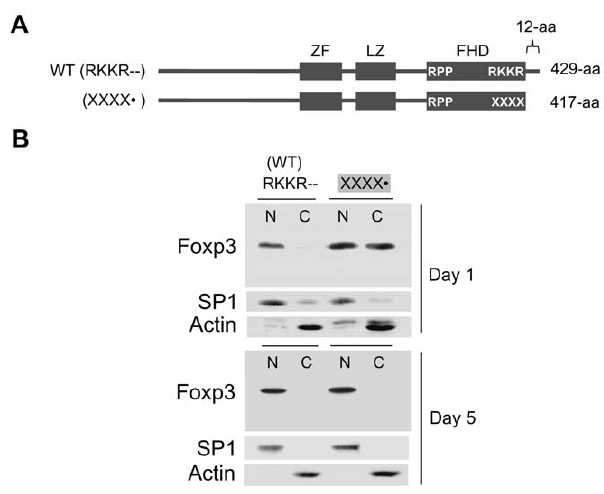
Figure 3. Foxp3 missing Domain 1 and the RKKR residues can fully translocate to the nucleus over time. A. Schematic diagram of WT Foxp3 (RKKR--) and C-short Foxp3 mutant (XXXX N ). B. Western blot showing nuclear and cytoplasmic distribution of WT-Foxp3 and C- short Foxp3 mutant at Day 1 and Day 5 following retroviral transduction. Lower panels, SP1 and Actin controls.